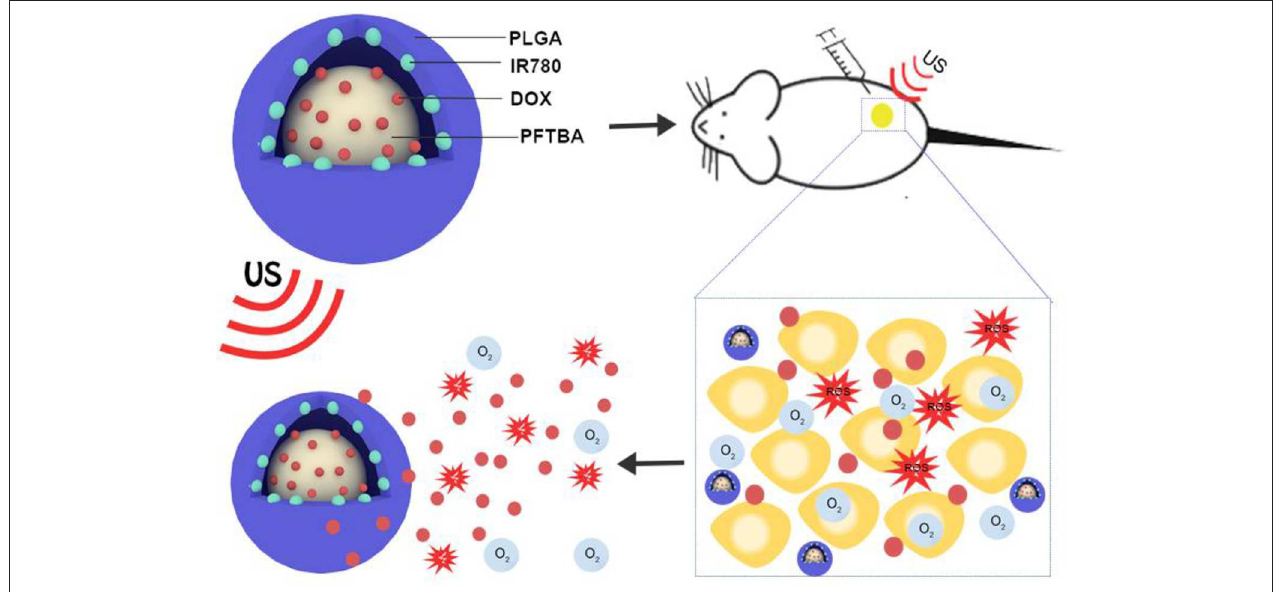
FIGURE 1 | Schematic illustration of the structure of PPID-NPs, ROS production and drug release process under ultrasound exposure.